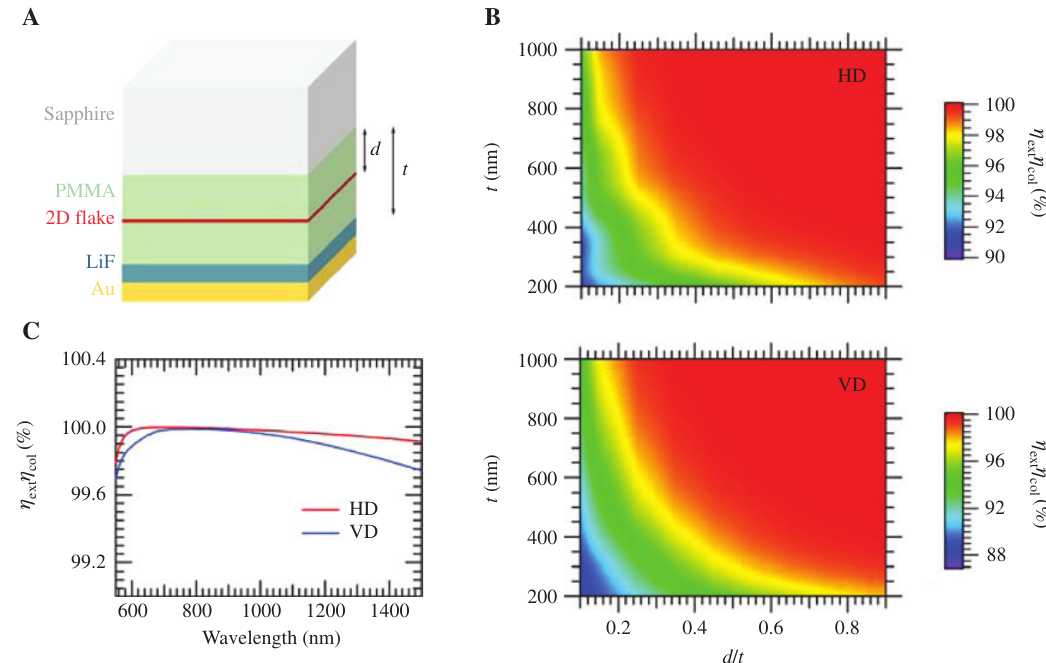
Figure 5: (A) Schematic illustration of the multilayer structure proposed to enhance the extracted photon flux for 2D materials. (B) Calcu- lated extracted photon flux efficiency for 2D materials with horizontal (HD, upper panel) and vertical (VD, lower panel) dipoles emitting at λ = 700 nm. (C) Calculated extracted photon flux efficiency for 2D materials embedded at a distance d = 640 nm in an 800-nm-thick PMMA layer as a function of the emission